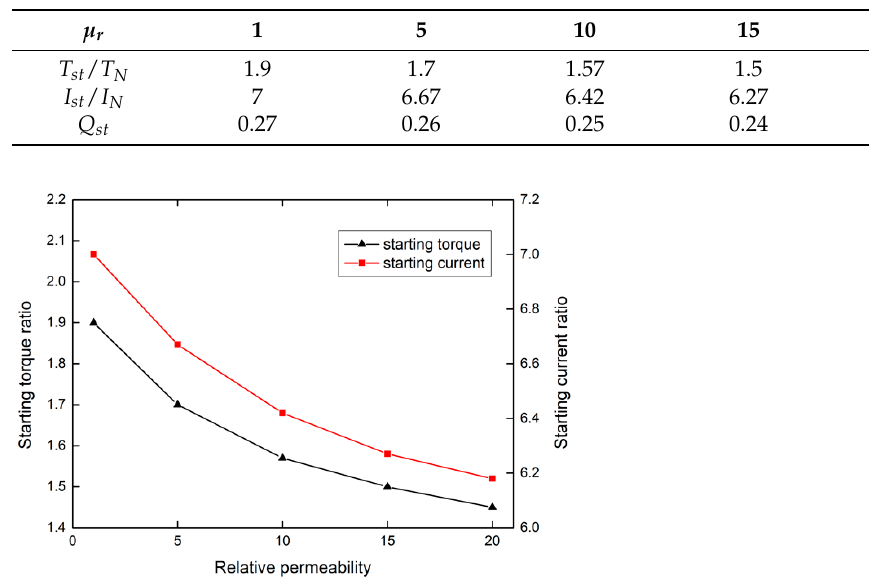
Table 3. Motor electromagnetic performance for different